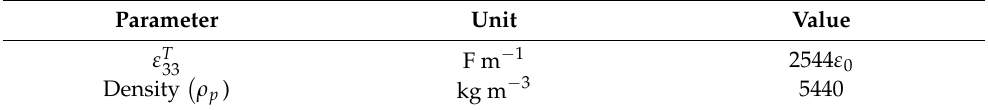
Table 6. Electromechanical properties of the PE patch.